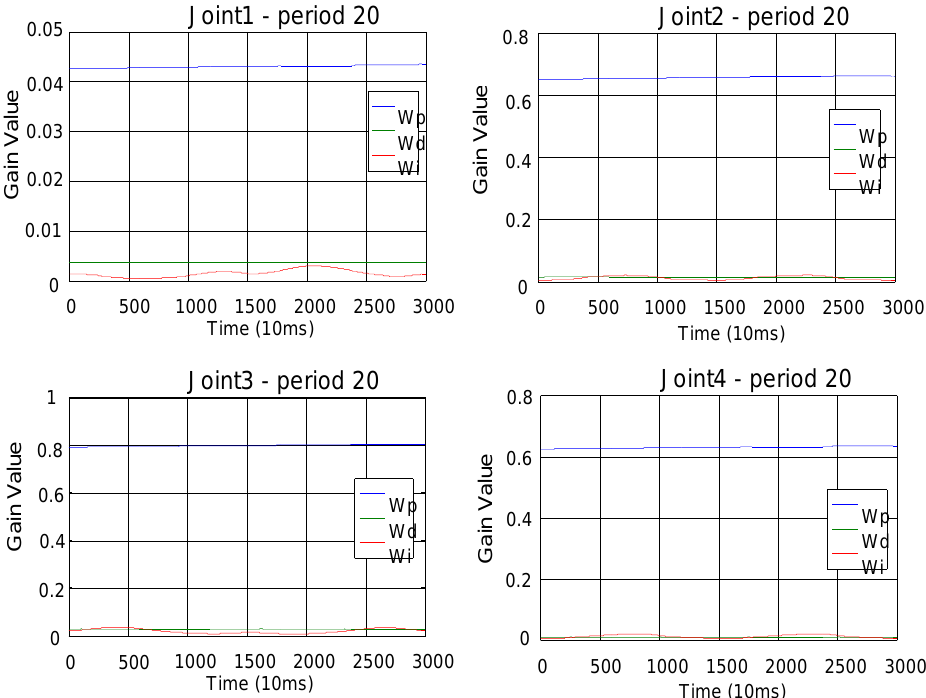
Figure 21. Trajectory 2—four axes—LMS-PID—curve charts of the controller parameters returned by tracking the 20th cycle.